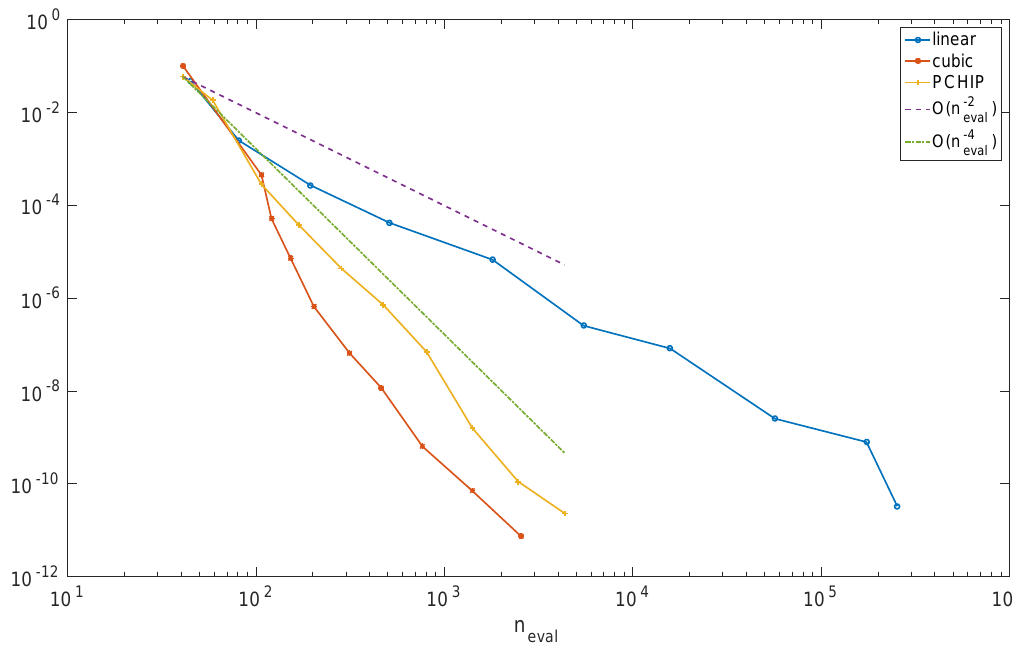
Fig. 5 In continuous line, the graphics of k v 15 − ˆ v 15 k ∞ as a function of n eval for ε k = ε varying from 10 − 1 to 10 − 10 , applied to each local rule and f 2 . For comparison, in discontinuous line are shown the growth rates O ( n − 2